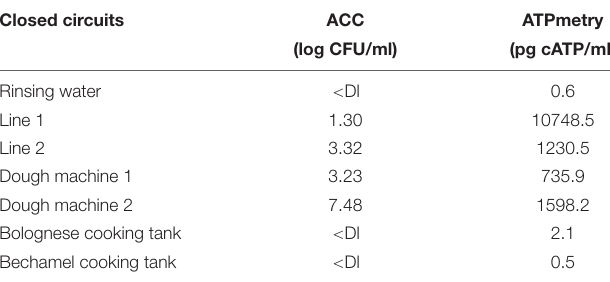
TABLE 4 | ACC (log CFU/ml) and ATPmetry (pg cATP/ml) for the closed circuits during enzymatic cleaning treatment. Closed circuits